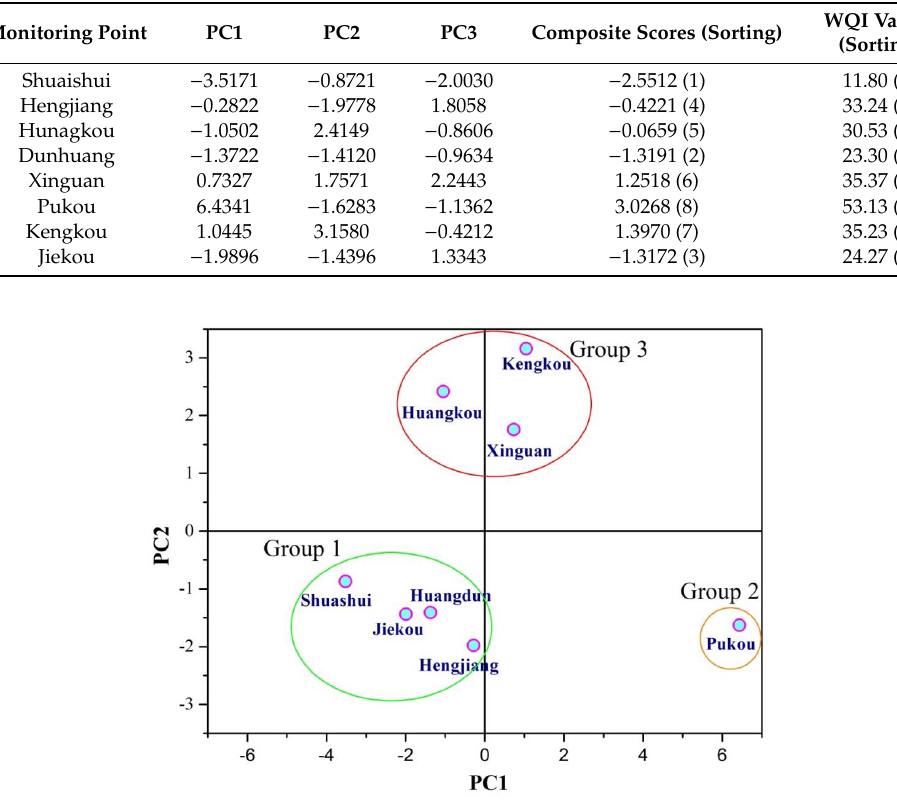
Figure 3. Factor scores (eight samples) of PC1 and PC2.